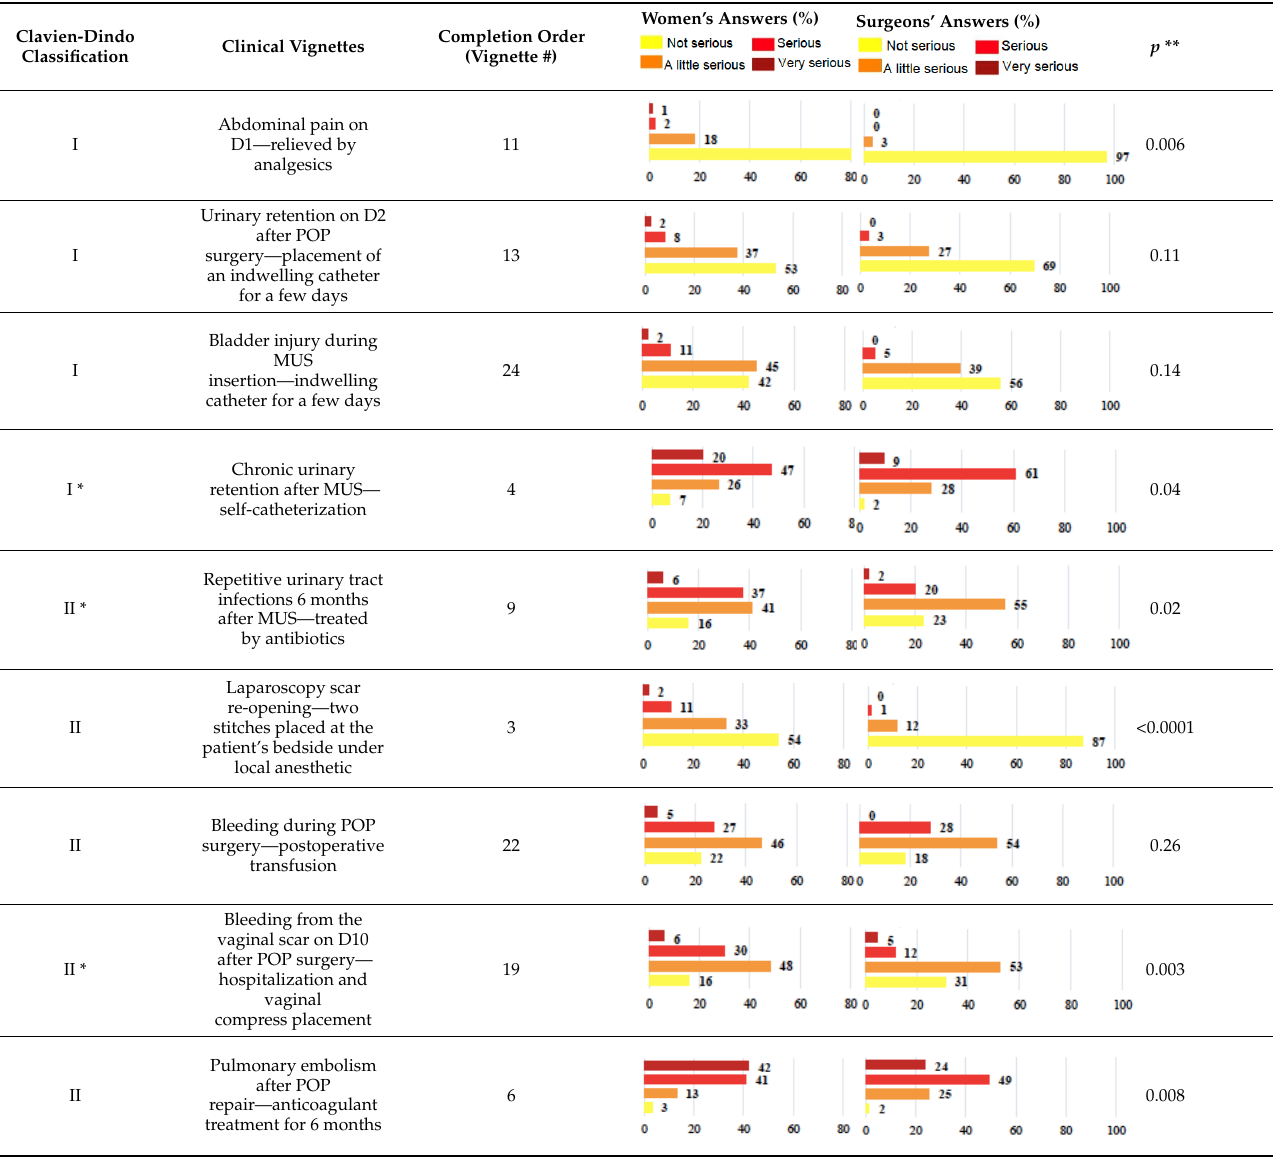
Table 2. Description and comparison of women’s and surgeons’ answers (percentages and Fisher’s exact test)—classifiable vignettes.